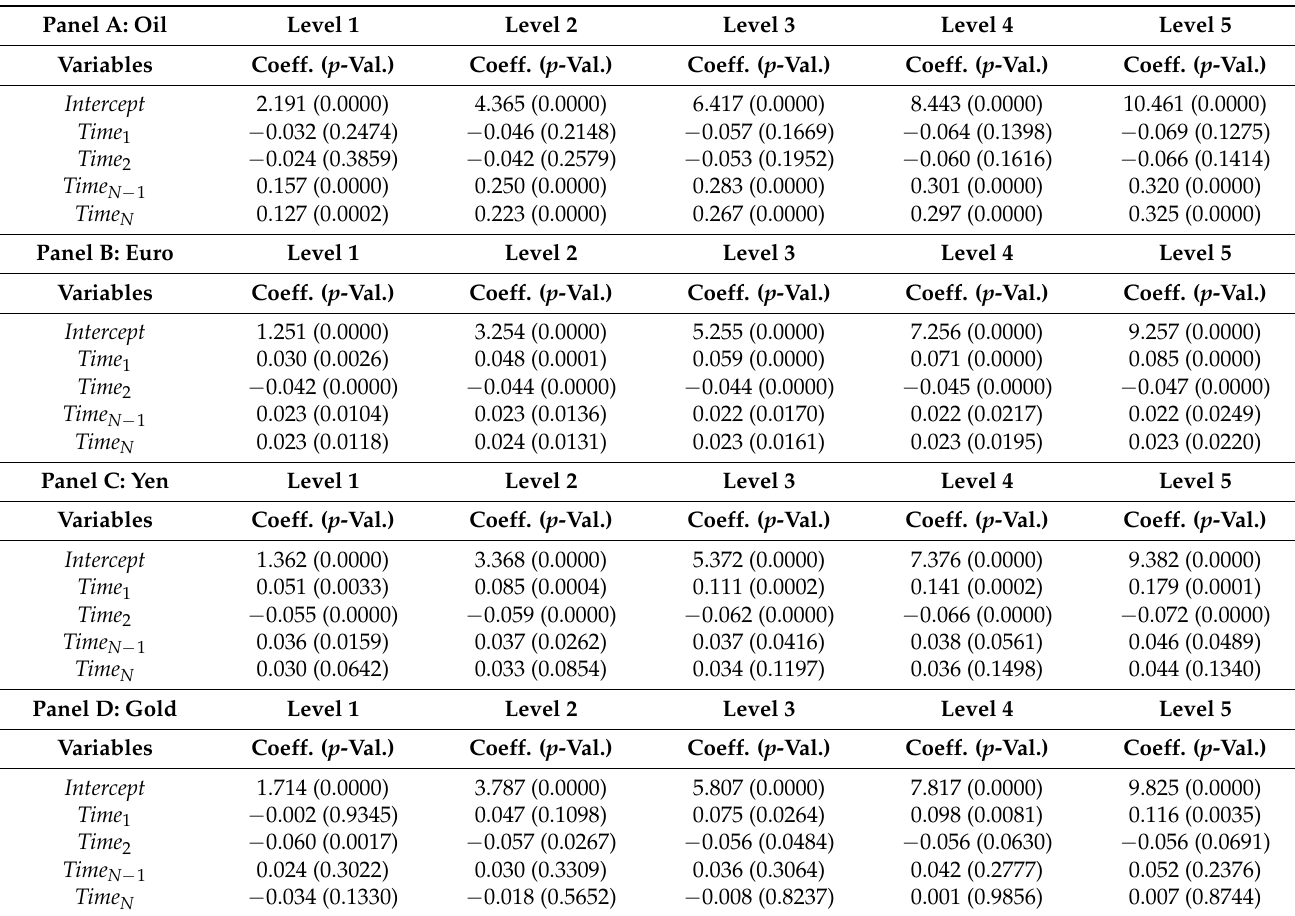
Table 5. Intraday patterns of spread at each